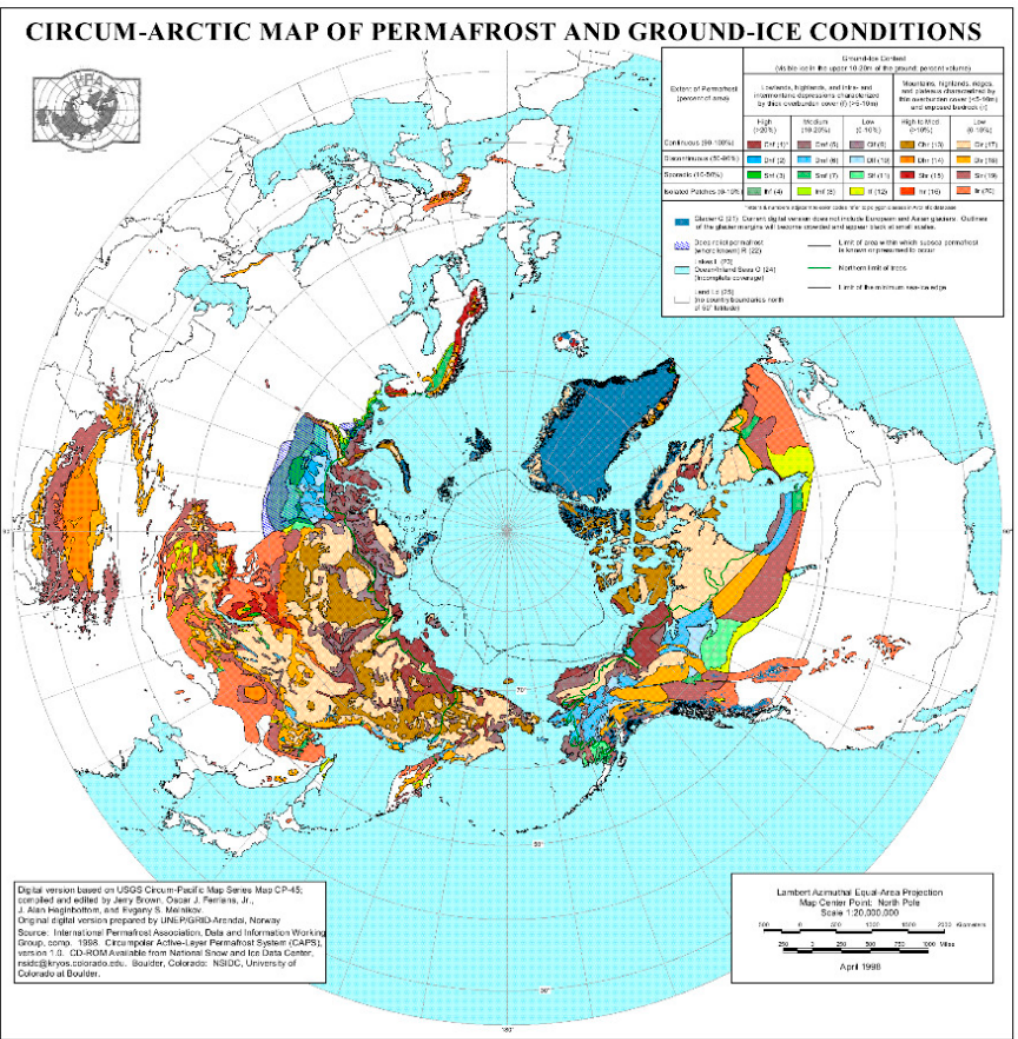
Figure 4. The Circum-Arctic Map of Permafrost and Ground-Ice Conditions.